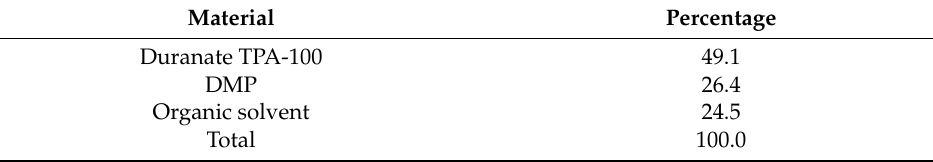
Table 4. Formulation of blocked isocyanate (wt.%).